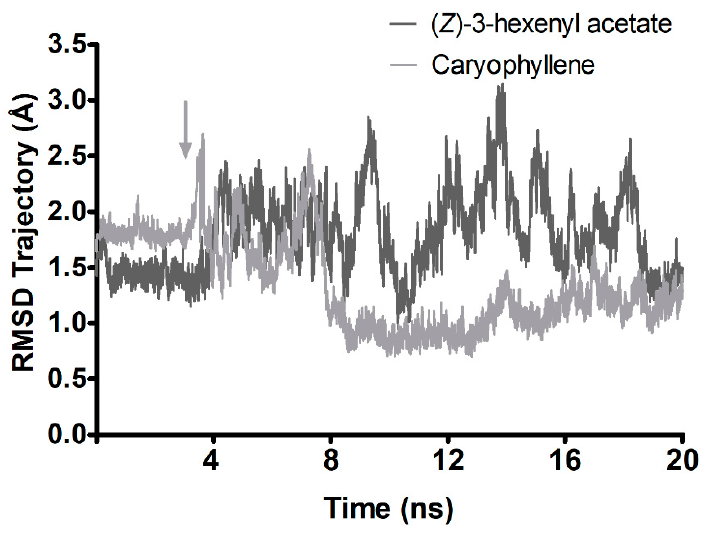
Figure 5. Root–mean square deviation (RMSD) trajectory (Å) from complex molecular dynamics with 20 ns of simulations for insecticides and semiochemicals bound to AgosCSP5. ( A ) RMSD trajectory for insecticides and ( E )- β -farnesene. ( B ) RMSD trajectory for plant volatiles ( Z )-3-hexenyl acetate and caryophyllene. The arrows indicate breakpoints in the protein–ligand trajectory. The arrows indicate breakpoints in the protein–ligand trajectory.